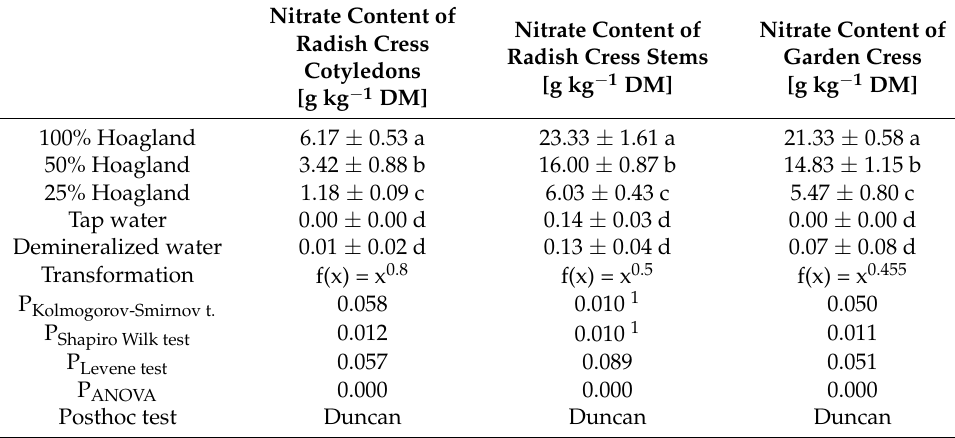
Table 6. Nitrate content of garden and radish cress. Different letters within a column indicate significant